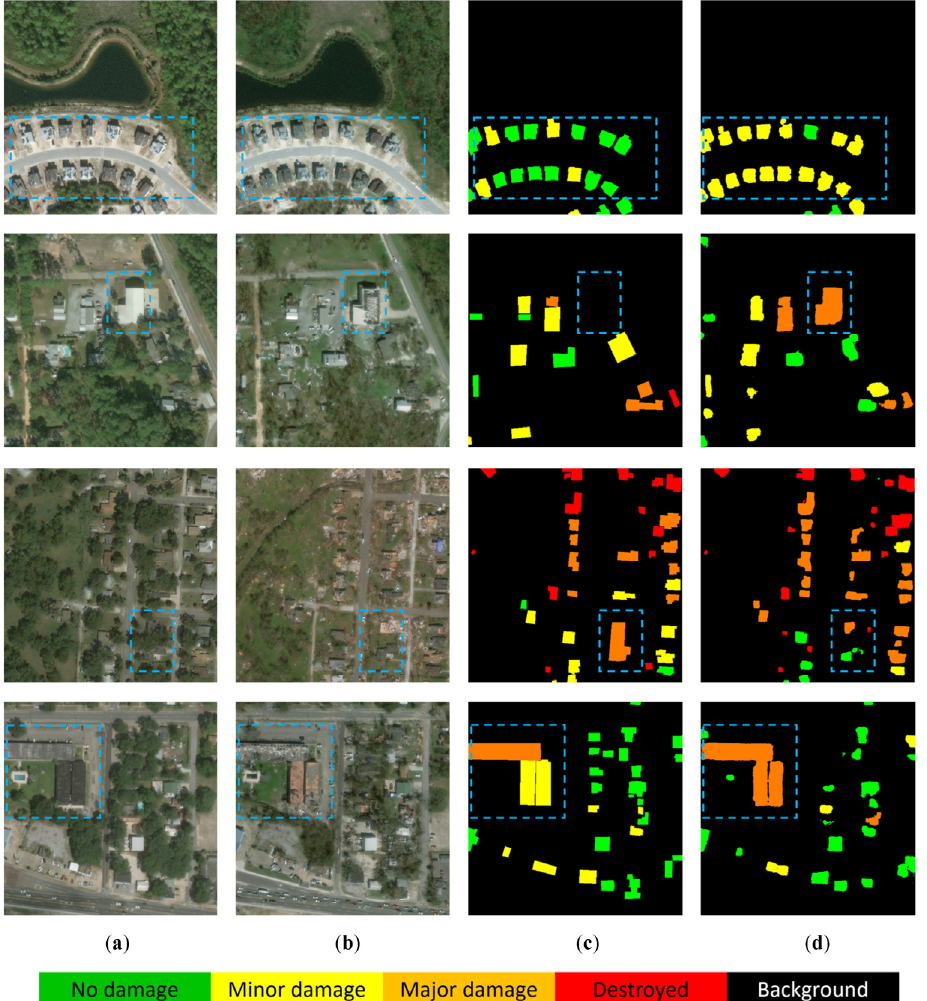
Figure 10. Some challenging examples for building damage assessment. ( a ) Pre-disaster image, ( b ) post-disaster image, ( c ) ground truth, and ( d ) assessment results.